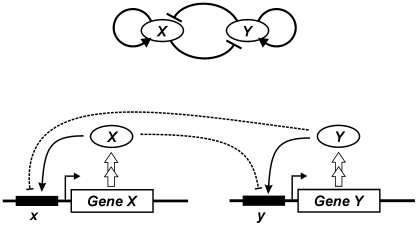
The generic architecture of the self-activation and mutual repression two-gene circuit.Top: coarse-grained circuit scheme for the circuit of two genes X and Y as a dynamical system; bottom: molecular mechanism model amenable for a more detailed chemical reaction kinetics formalism, indicating the variables for the model due to the distinction between genes/promoters (x and y) and the transcription factor proteins (X, Y). Note that the modality for how the two inputs at each promoter, self-activation and cross inhibition is not specified by the scheme.